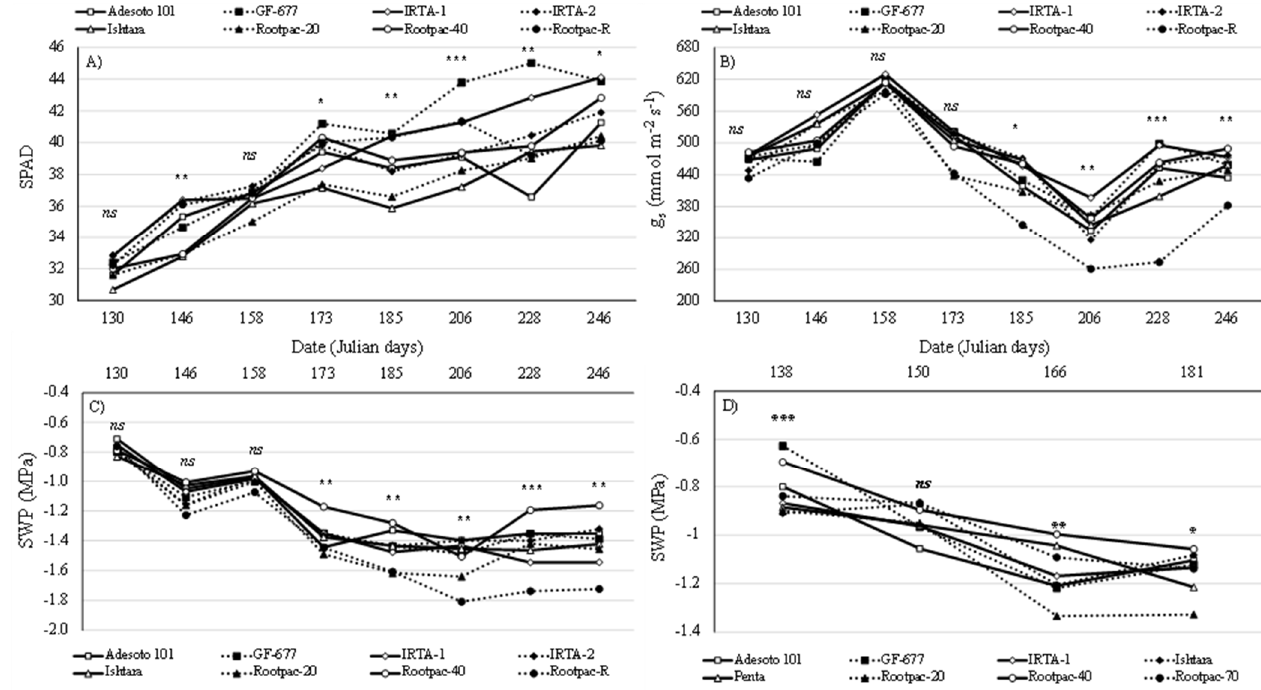
Figure 1. Seasonal patterns of leaf chlorophyll content (SPAD) ( A ), stomatal conductance ( B ) and tree water status ( C ) for ‘Vairo’ almond cultivar and the seasonal patterns of tree water status ( D ) for ‘Big Top’ nectarine cultivar grafted onto eight different Prunus rootstocks. Ns = not significant; * p ≤ 0.05; ** p ≤ 0.01; *** p ≤ 0.001.